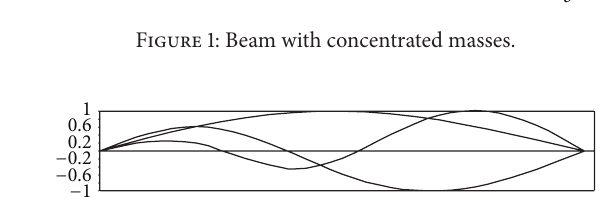
Figure 2: Target mode shapes (Case